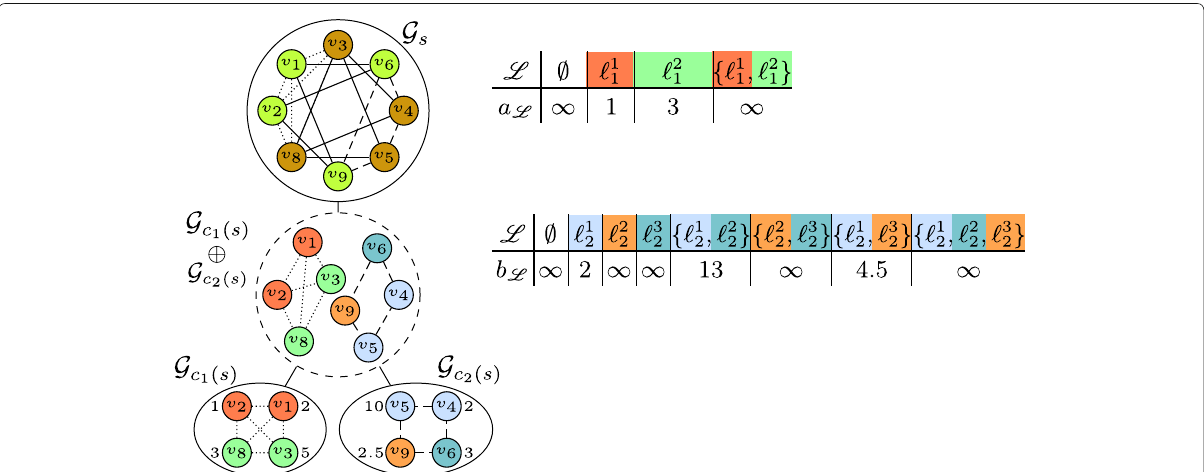
Fig. 16 Two child nodes, each with four vertices and two or three different colors, are merged at their parent tree node s . The colors of the vertices correspond to their labels, and the annotated numbers represent the vertex weights. The middle step shows the union of the vertices and edges and is usually omitted in visualizations. At the top, G s is the merging result, which contains only two labels. Note that different labels (colors) are used at tree note s compared to at c i ( s ) , i = 1,2. The tables on the right-hand side show the labels used: the top table for the left child G c the bottom table for the right child. Several label sets are infeasible and thus are assigned a weight of